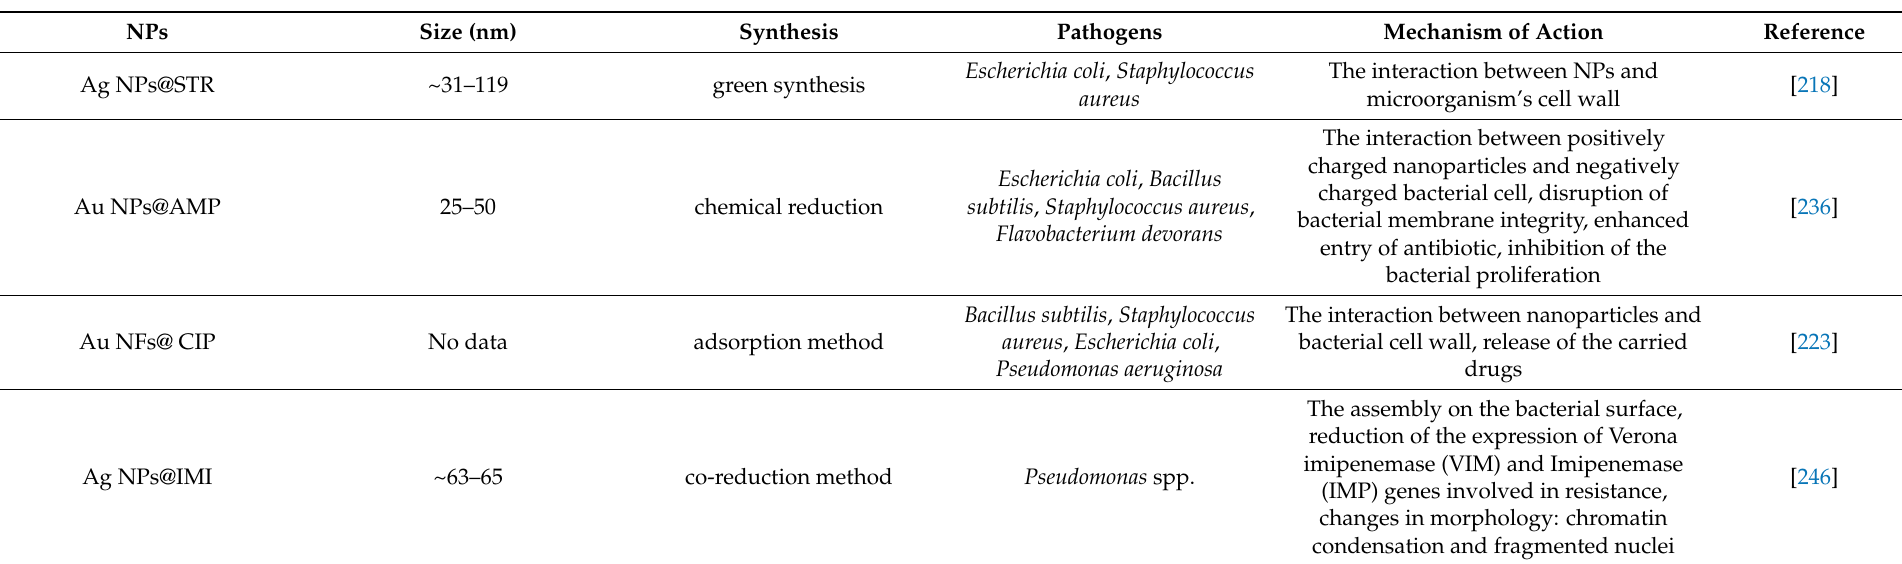
Table 4. Antimicrobial activity of metallic nanoparticles functionalized with antibiotics/fungicides or compounds other than antimicrobial agents. Abbrevi- ations: STR, streptomycin; AMP, ampicillin; Au NFs, gold nanoflowers; CIP, ciprofloxacin; IMI, imipenem; GNRs, gold nanorods; FLU, fluconazole;